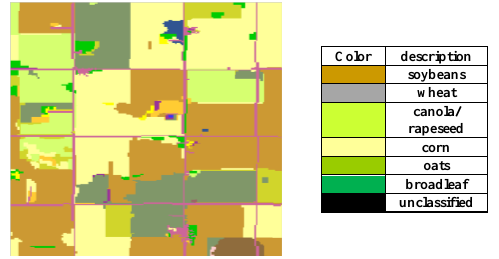
Figure 4. reference crop map (left) and its legend (right)